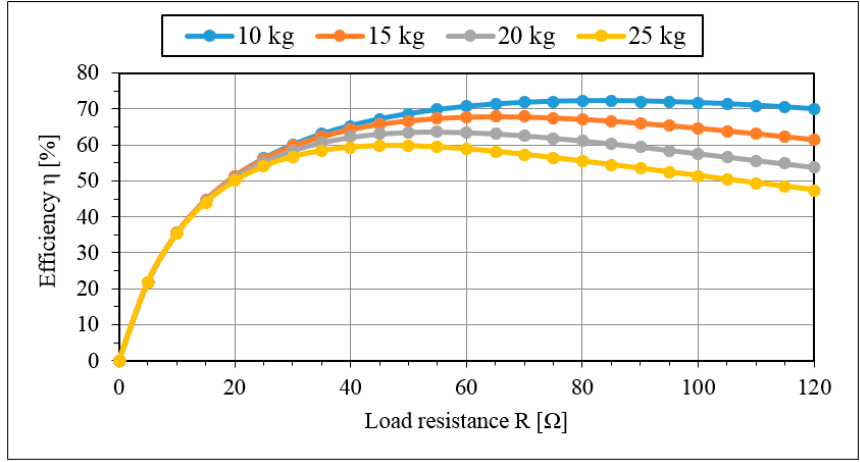
Figure 9. Efficiency of the linear generator in the experimental tests.